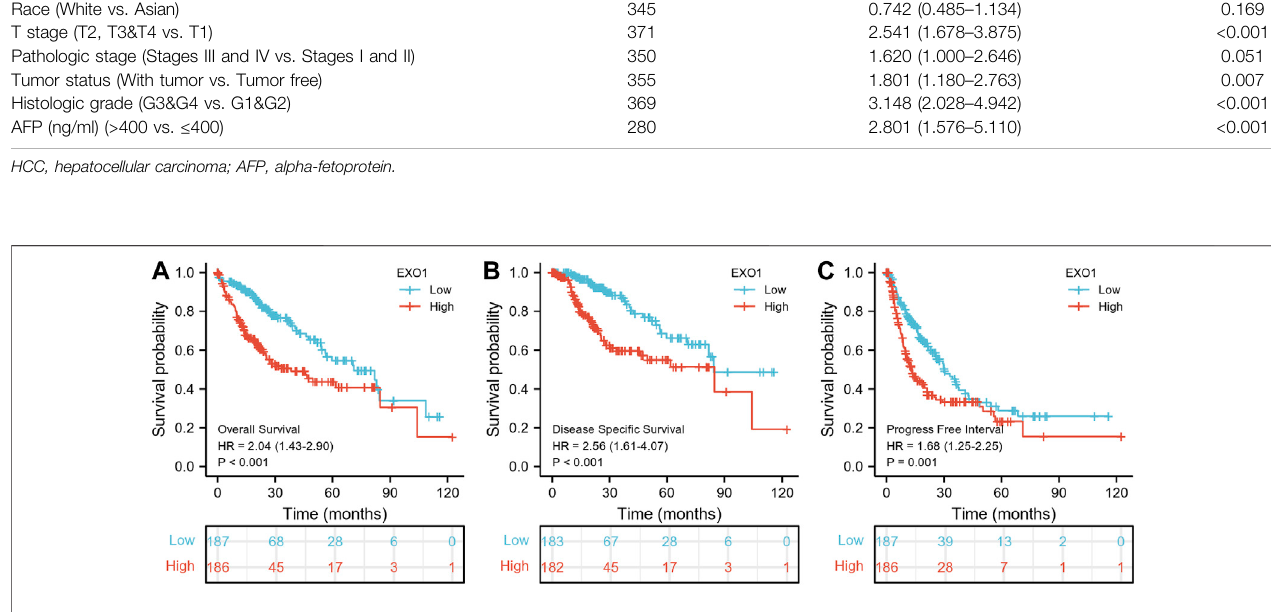
TABLE 3 | Logistic regression analysis of the relationship between clinicopathological characteristics and the EXO1 expression levels in HCC patients. Characteristics